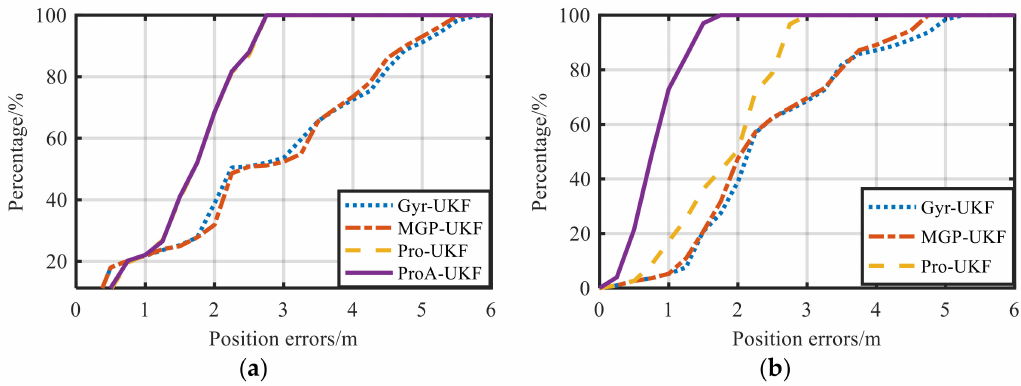
Figure 10. Position cumulative error percentages of di ff erent methods for di ff erent smartphones: ( a ) The error percentage for HV9; ( b ) The error percentage for XM8.